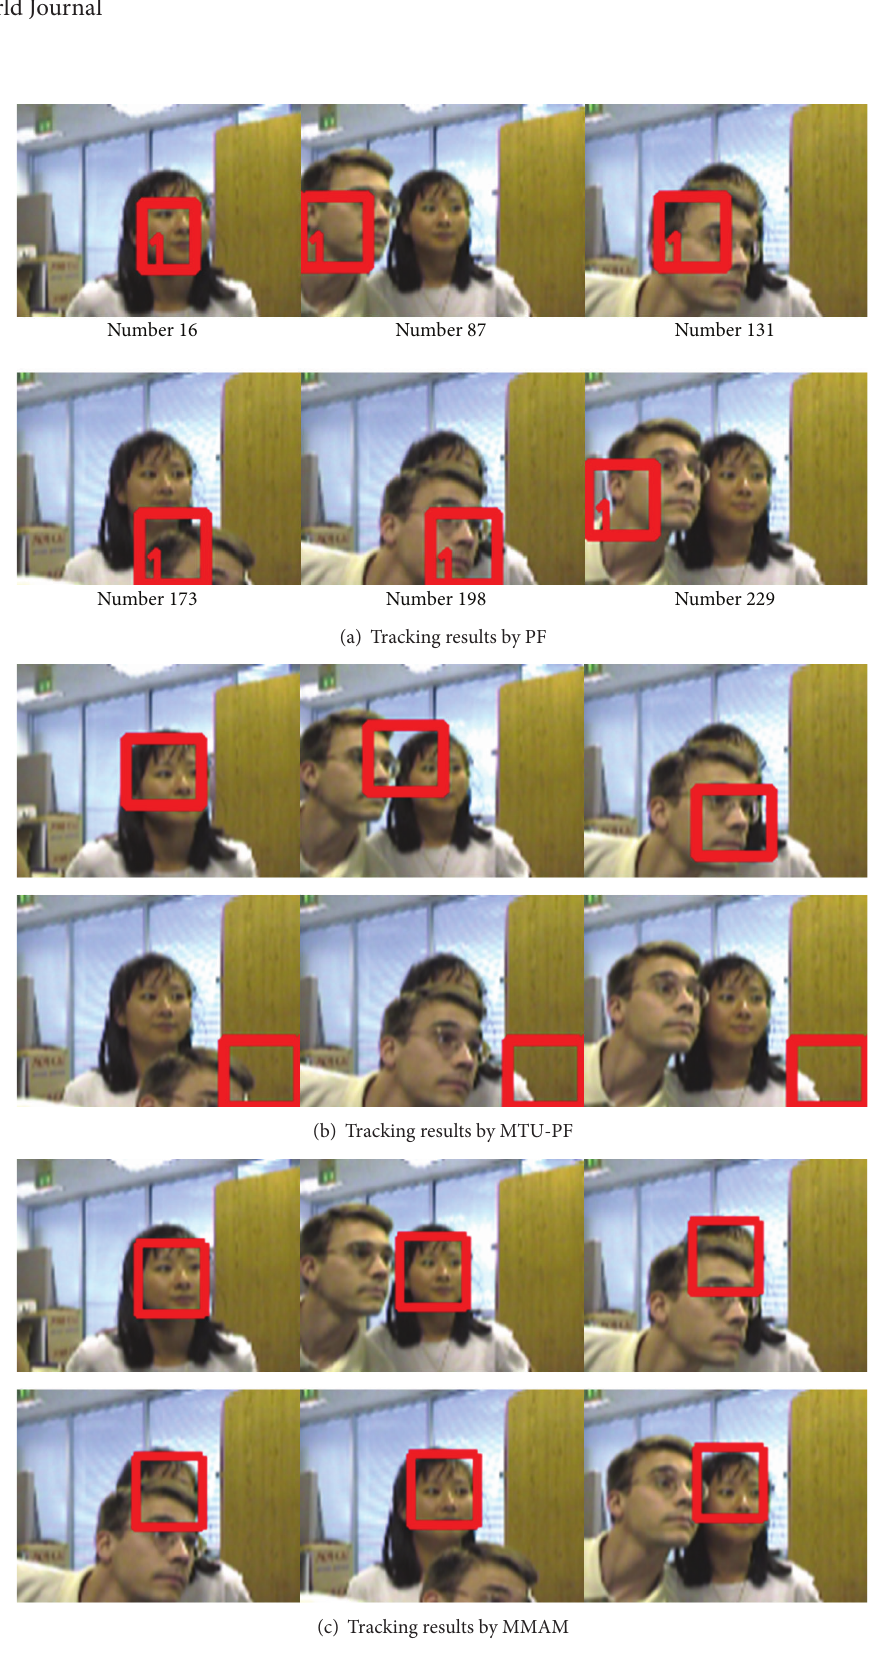
Figure 13: Tracking a fully occluded